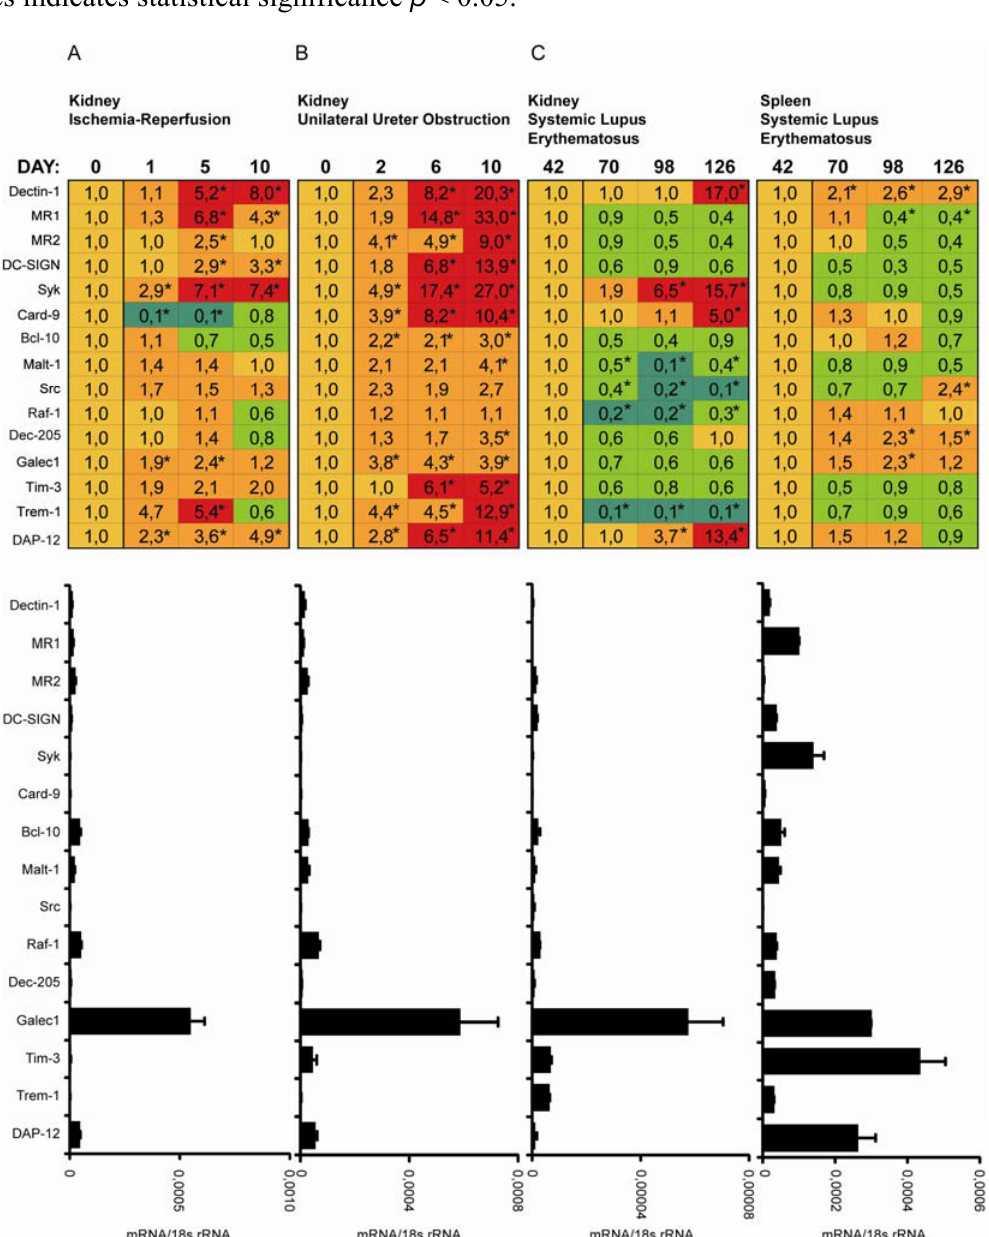
Figure 3. ( A ) CLRs mRNA expression in mouse kidney upon induction of IRI; ( B ) CLRs mRNA expression in mouse kidney upon induction of UUO; ( C ) CLRs mRNA expression in mouse kidney upon induction of lupus nephritis (LN). Real-time PCR was performed on cDNAs derived from murine kidney tissue from five to ten C57BL/6 mice that underwent ischemia reperfusion injury (IRI) (A), unilateral ureteral obstruction (UUO) (B) or progressive systemic autoimmunity with lupus nephritis in MRLlpr mice (C) as described in methods. Biological replicates were quantified and normalized to 18s rRNA level. The results in the table are expressed relative to the respective expression level of each transcript in sham operated kidney (A, B) or six week old MRLlpr mice (C). In the table, red shades indicate higher and green shades indicate lower mRNA levels as compared to the respective mRNA levels in spleen. Basal mRNA levels in control kidney are illustrated in the histogram below the table. Data in histograms represents means ± SEM. * In the tables indicates statistical significance p <